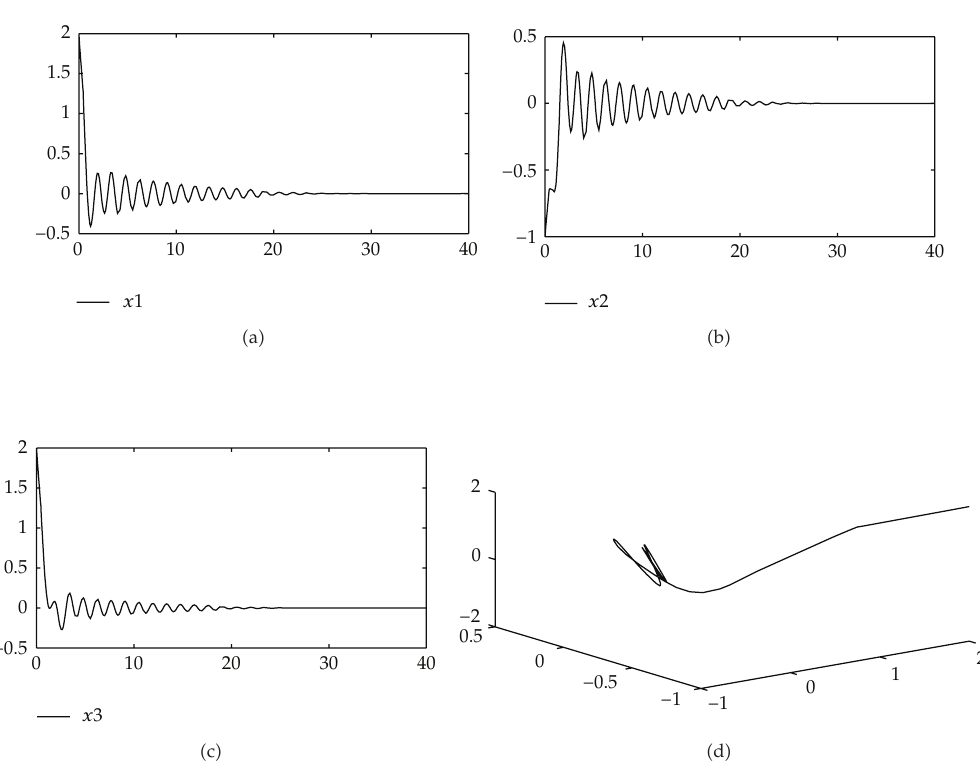
Figure 1: For system (cid:5) 3.4 (cid:6) , when τ (cid:7) 0 . 44 < τ ∗ , the equilibrium is asymptotically